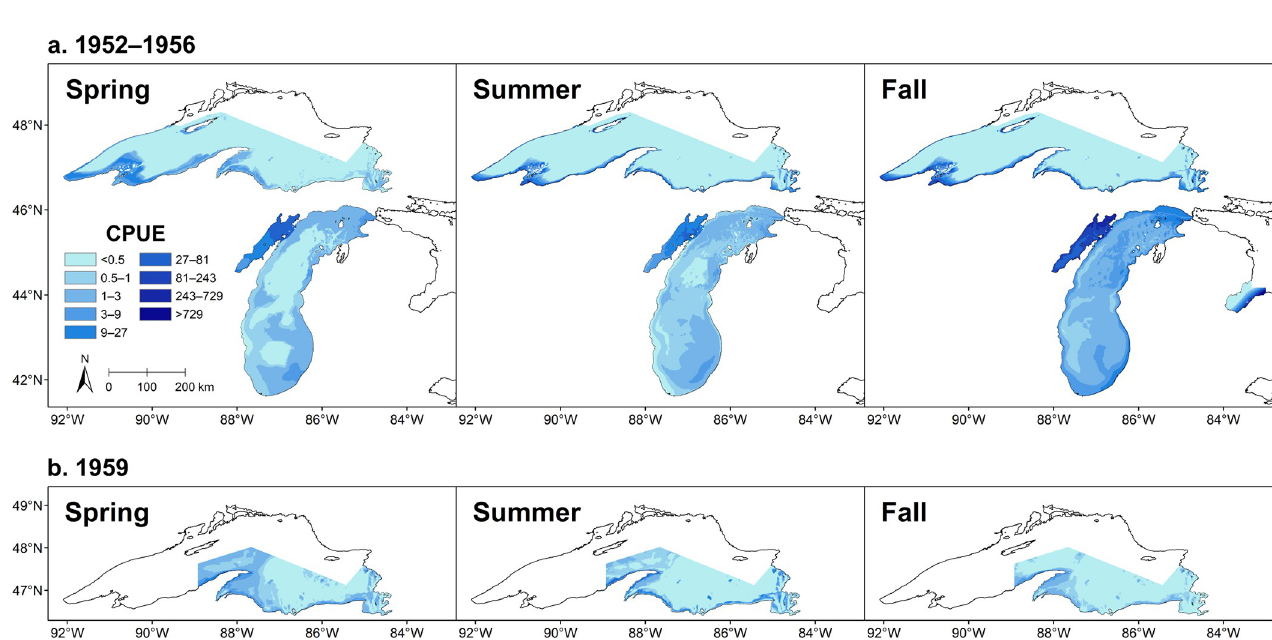
Fig 6. Maps of predicted gill-net Cisco catch per unit effort (CPUE) in (a) the upper Great Lakes in 1952–1956 and (b) Lake Superior in 1959. The CPUE was predicted from selected generalized additive models fitted to gill-net data collected by the R/V Cisco . A unit of effort was defined as one lift of a gang of bottom- set gill nets, with a total mesh area of 100 m 2 , a mesh size of 51 mm, and a fishing duration of one night. The predictions were restricted to areas covered by R/V Cisco surveys. Note that our model selection results showed that the predicted Cisco CPUE in Lake Michigan would not be significantly different between the periods 1952–1956 and 1959–1962; accordingly, the Lake Michigan maps in Fig 6A represent the distributions of gill-net Cisco CPUE over the whole study period 1952–1962. Maps were generated with geographic information system (GIS) software ArcGIS version 10.8 (http://www.esri.com/software/arcgis/). The GIS layers of predicted Cisco gill-net CPUE were generated in this study. The GIS layer of the Great Lakes outline was obtained from the Great Lakes Aquatic Habitat Framework’s [17] public domain spatial database